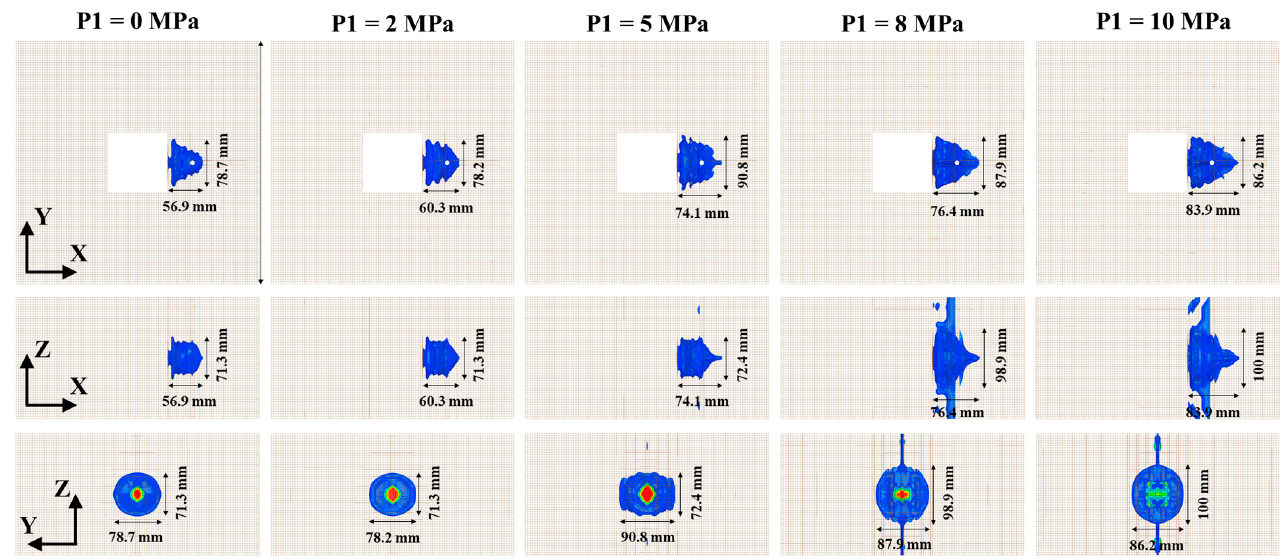
Figure 6. The craters for W = 4 cm under different P1.